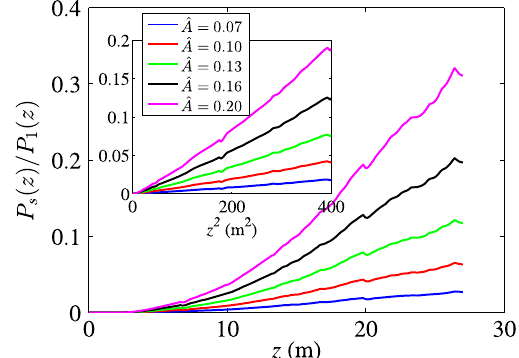
FIG. 5. The power ratio of the lower sideband to the amplified seed along the undulator for different modulation amplitude as predicted in 3D G ENESIS simulations. The inset plots the power ratio versus the square of the undulator